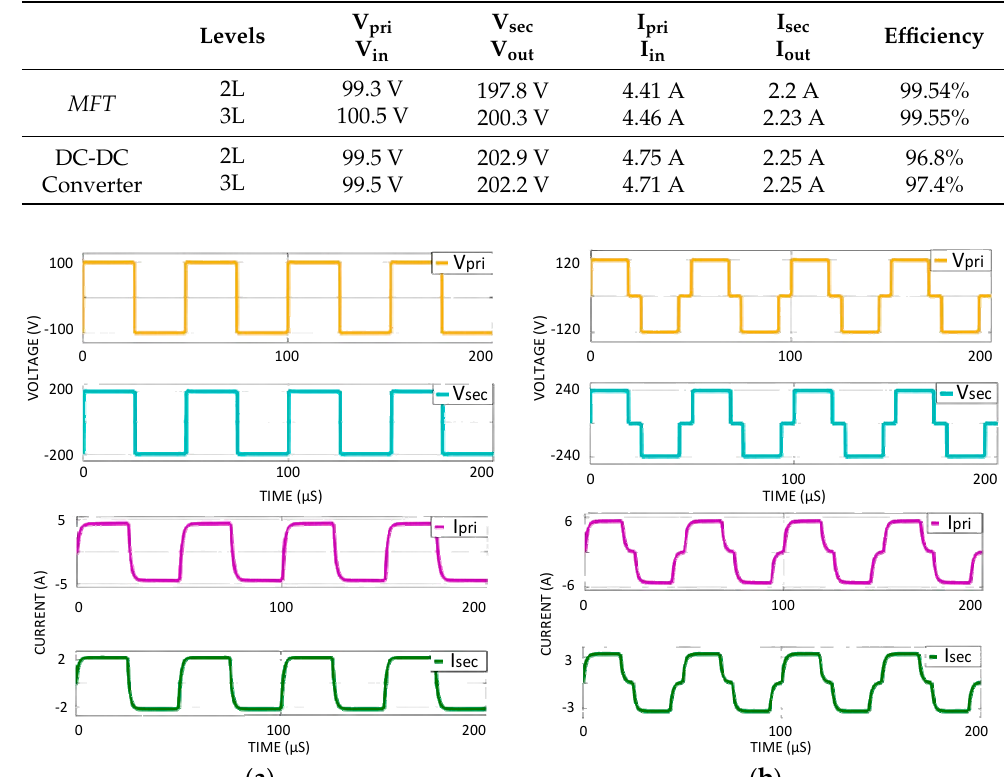
Table 2. Input and output voltages and currents for efficiency simulation in the converter and MFT.